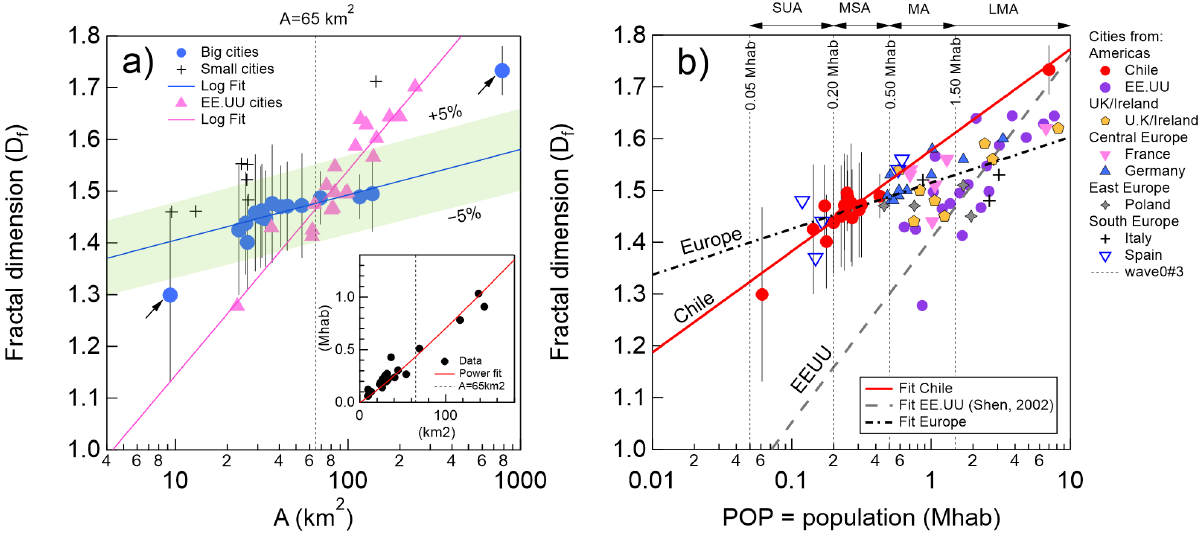
Figure 8. ( a ) Relation between D f vs. POP for all the entities. Data obtained from [25,26] were in- cluded for comparison. Straight lines are given by Equation (6) (SUA = small urban areas, MSA = mid- size urban areas, MA = metropolitan areas, LMA = large-metropolitan areas; according to [69]). ( b ) Relation between D f vs. A . American cities were included for comparison. Continuous lines are given by Equation (7) (inset: POP vs. area A ; Mhab = millions of inhabitants. Continuous line is given by POP = kA t , with k , t fitting